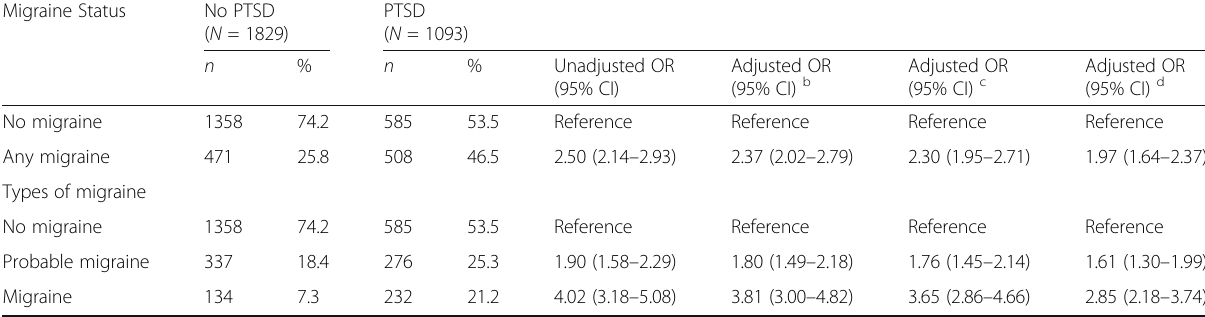
Table 2 Association between migraine and PTSD a assessed by the PCL-C during pregnancy ( N = 2922) Migraine